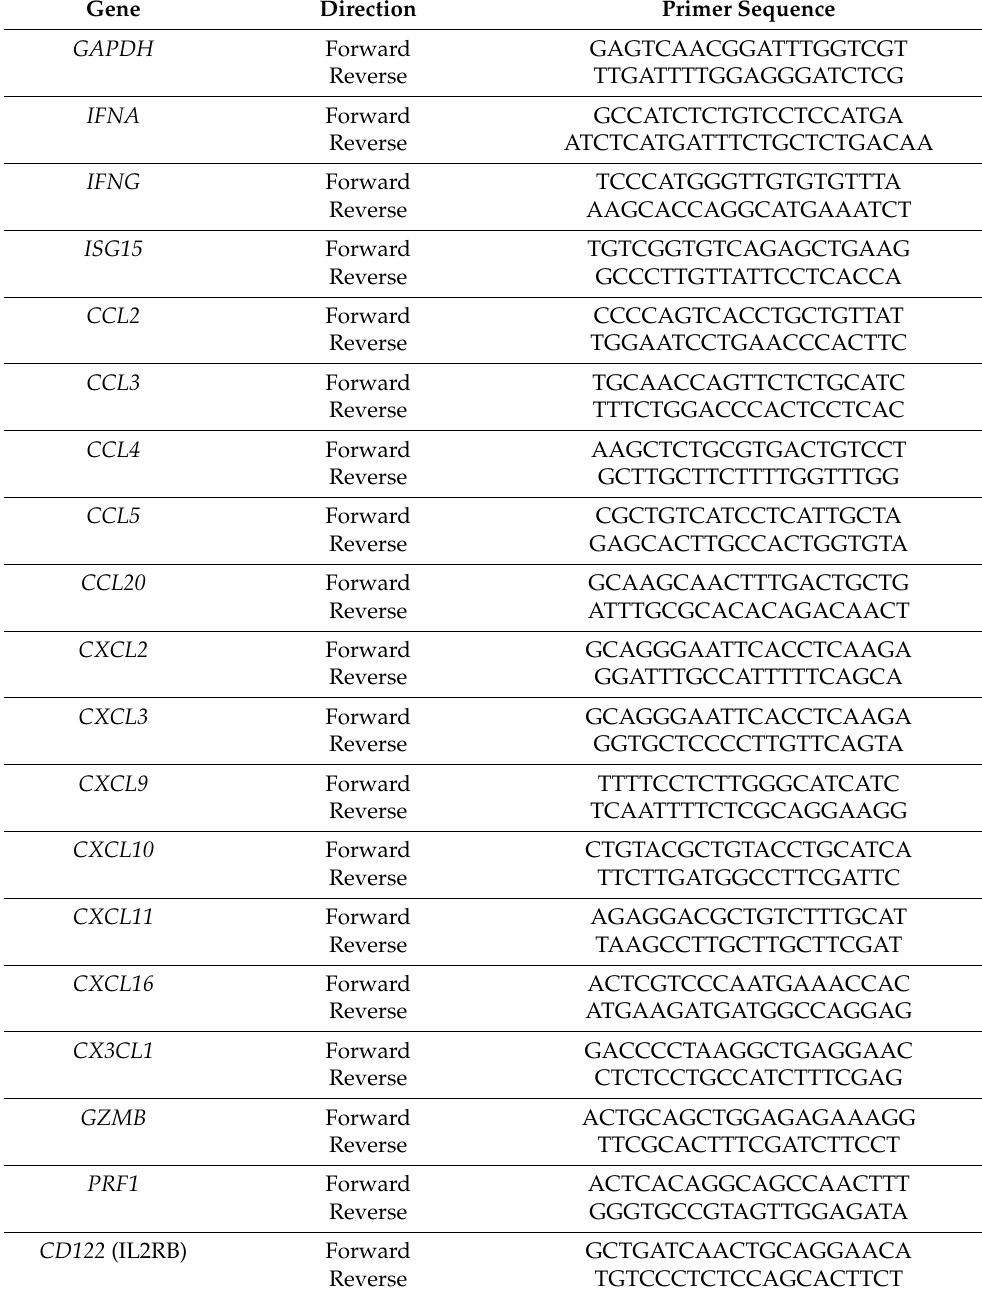
Table 2. The primer sequence for